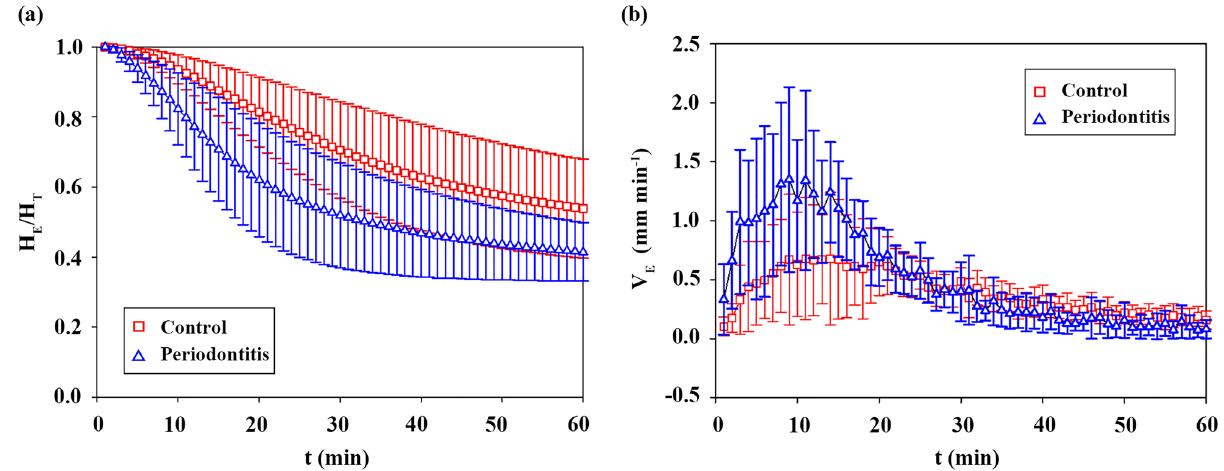
Figure 8. ( a ) Temporal variation of H E /H T for the control and periodontitis subjects. ( b ) Instantaneous time rate of sedimentation of V E for the normal subjects and periodontitis patients. All data shown are values of mean ± SD (n = tioned at the top in ascending order. The methods are not significantly different if their mean ranks share the same color bar that is less than or equal to the CD.